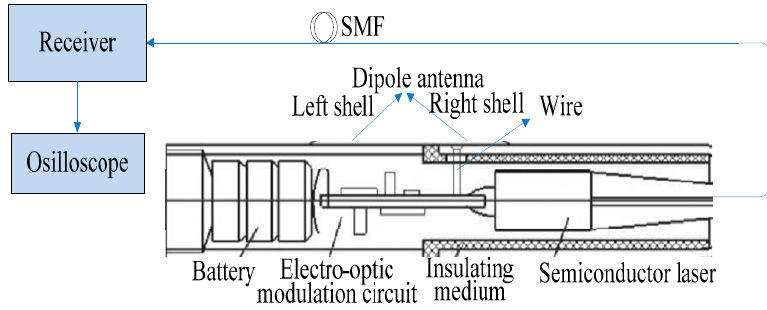
Figure 1. Configuration of the proposed sensor system.